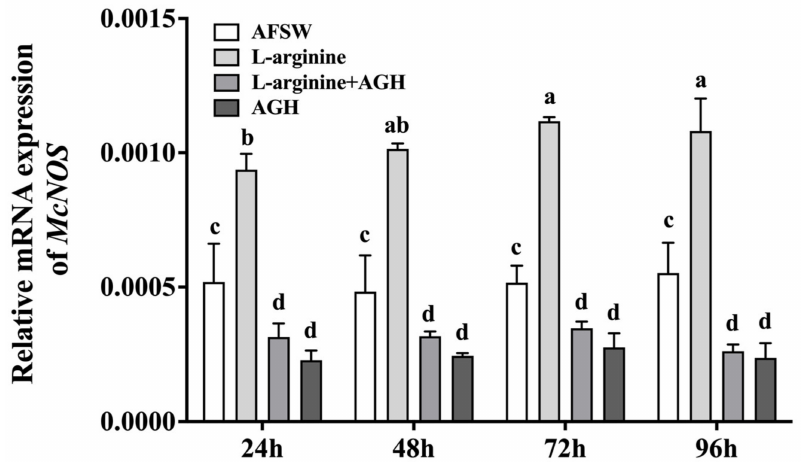
Figure 2. NOS mRNA expression levels at different timepoints after L-arginine and AGH exposure. Values represent mean ± SEM ( n = 120), and bars with different letters indicate significant differences ( p < 0.05).